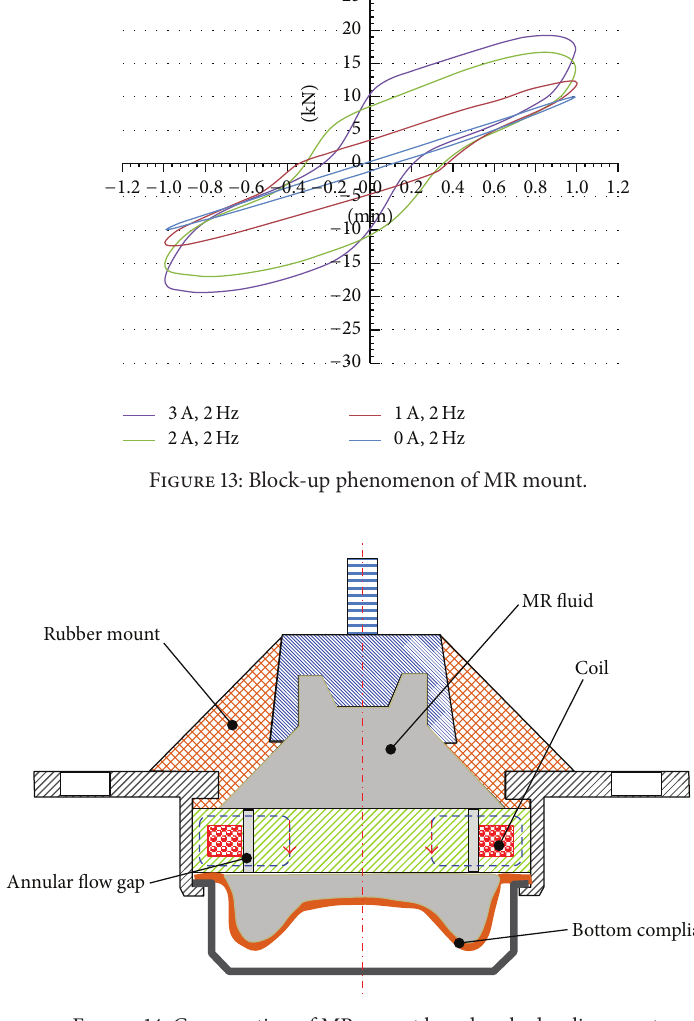
Figure 14: Cross section of MR mount based on hydraulic